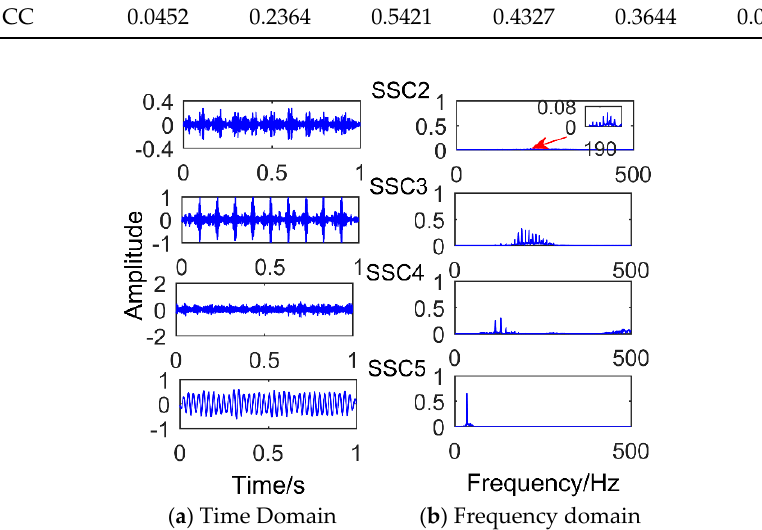
Figure 14. The decomposition results of SSD.